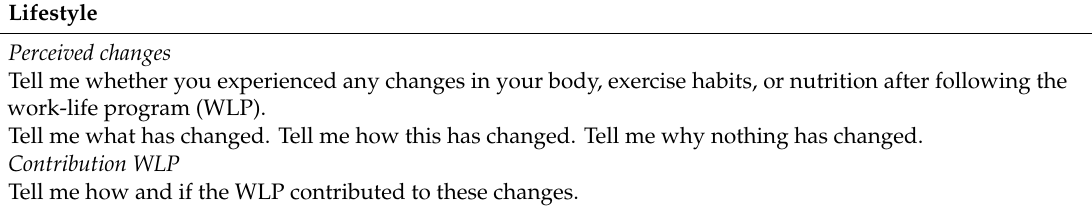
Table 1. Topic list semi-structured, in-depth